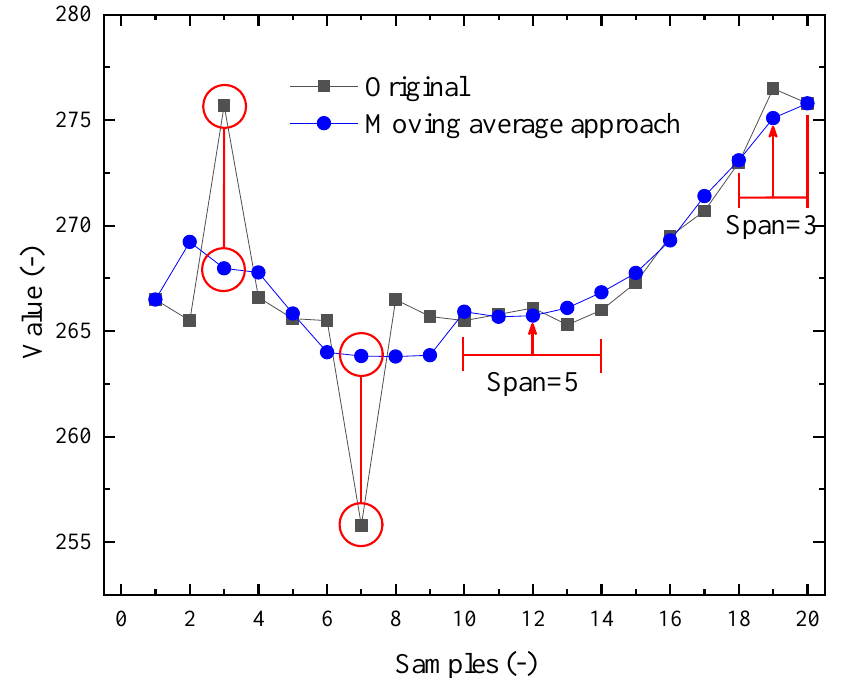
Figure 2. Data smoothing diagram of the moving average method.